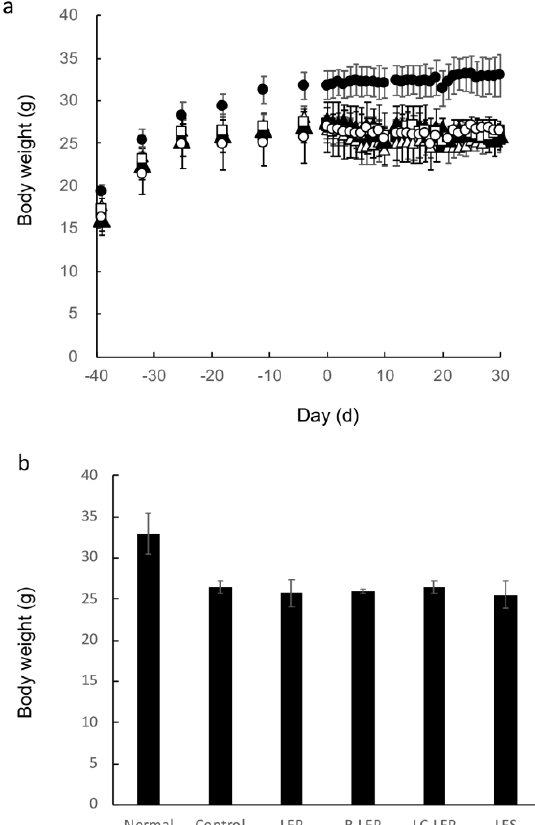
Figure 2. Changes in body weight in normal mice and HR-AD-fed mice after oral administration of lactic acid bacteria metabolites over time ( a ), and after 40 days ( b ). Data represent mean and standard deviation ( n = 4 to 6). Symbols: closed circle, normal (regular diet fed, distilled water); open circle, control (HR-AD fed, 10.8% ethanol in water); closed square, lactic fermentation products (HR-AD fed, LFP); closed triangle, residue of LFP (HR-AD fed, LFP); open square, lipid components of LFP (HR-AD fed, LC-LFP); open triangle, lactic fermentation secretion (HR-AD fed, LFS).